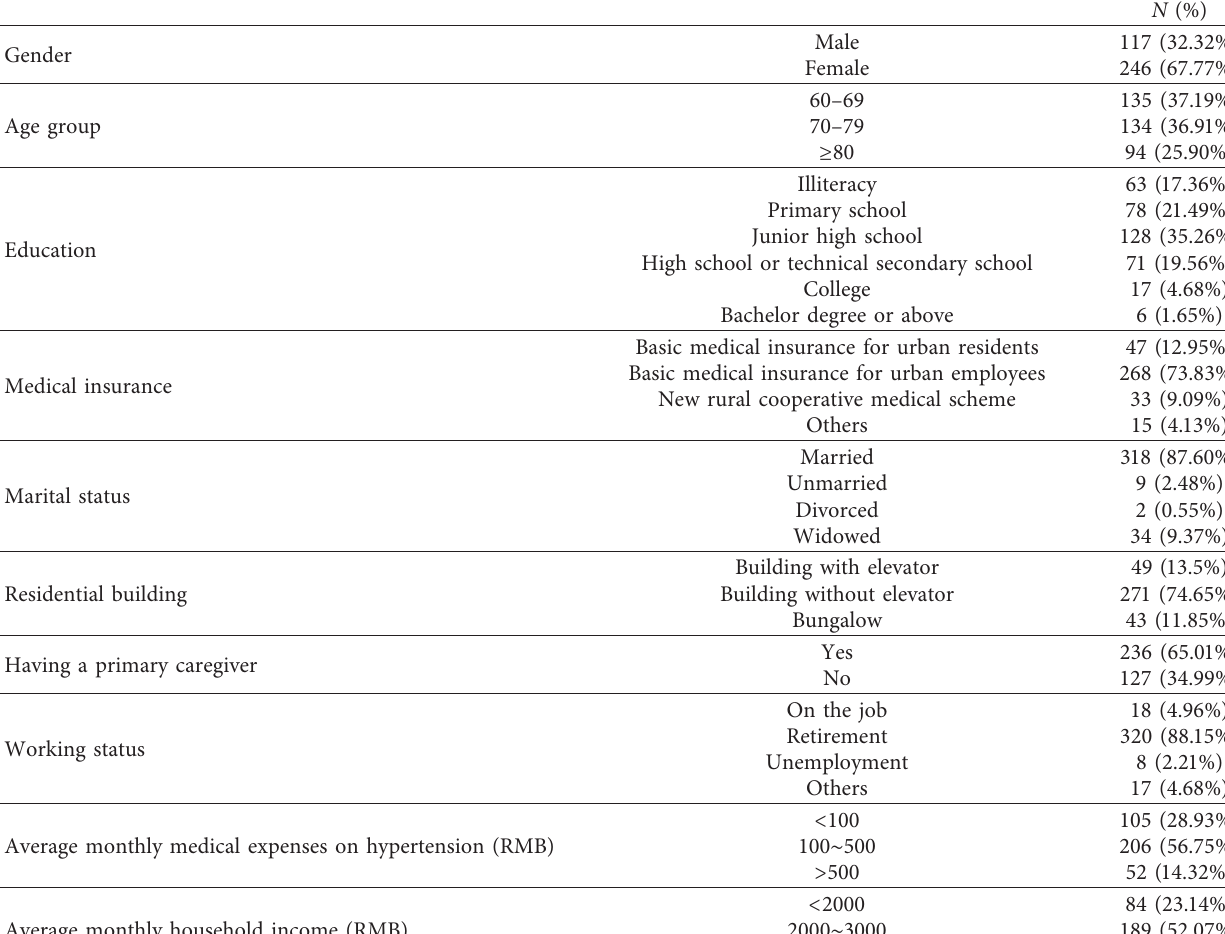
Table 1: Older adults’ characteristics.